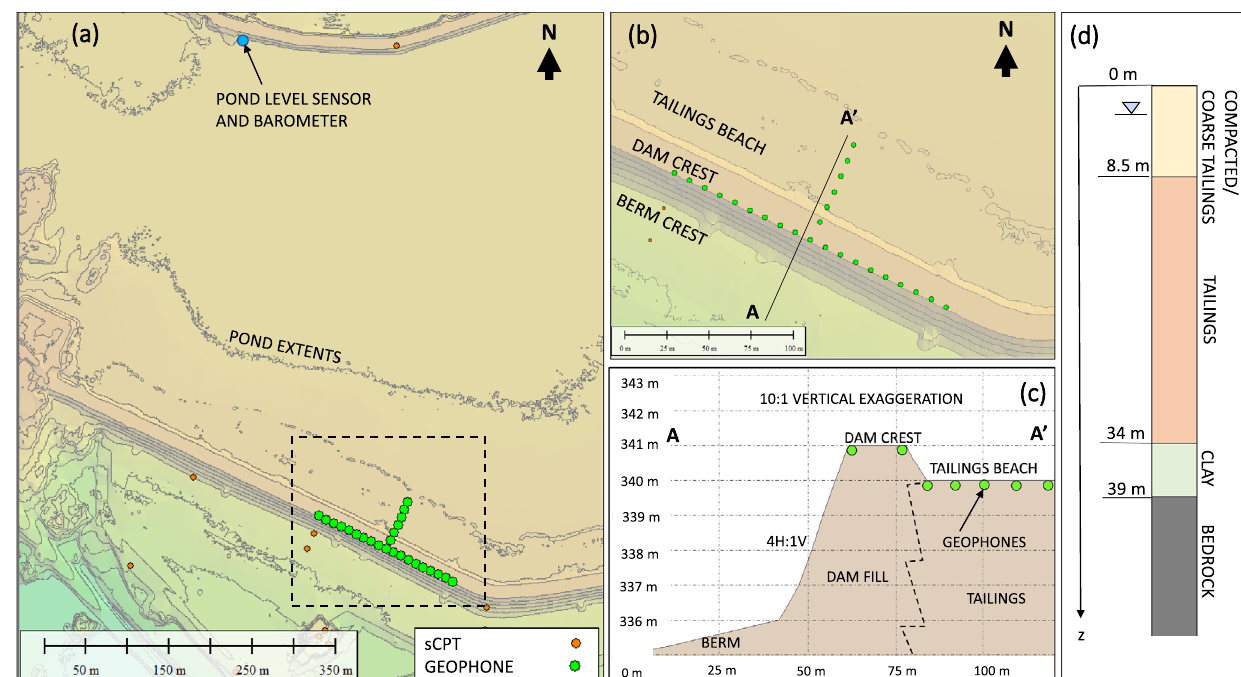
Fig. 1 Site overview. a Geophone array overlain on lidar data with hill shading (1 m contours, collected in November 2020). Map was created using Global Mapper v21.0 software. Location of subset of sCPTs used in regression analyses. Additional sCPTs used in analyses are not shown as they are outside of the fi gure extents. b Twenty- fi ve geophone array (20 on dam crest, fi ve on tailings beach), showing cross-section A-A ′ . c Cross-section A-A ′ of the tailings dam. The dashed black line shows approximation of dam fi ll and tailings extent for an upstream tailings facility, and does not represent actual delineated extents of fi ll and tailings. d Site stratigraphy obtained from historical borehole information.